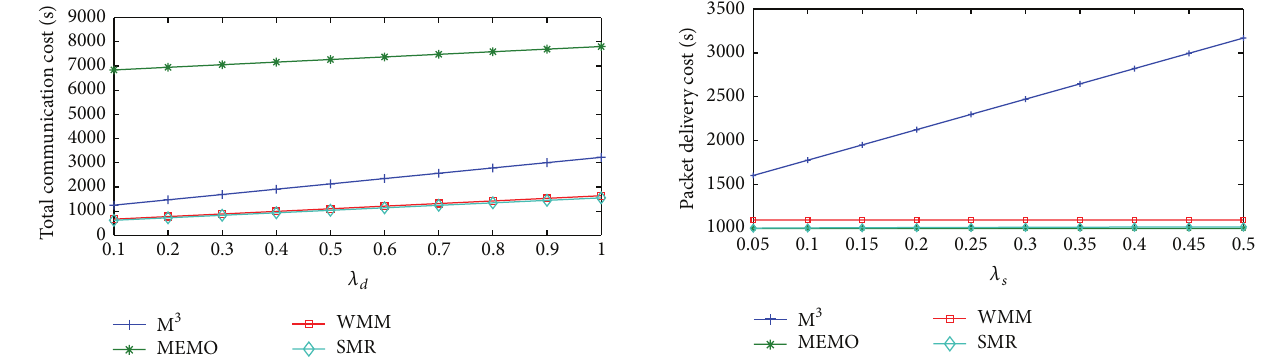
Figure 11: Packet delivery cost/sec versus 𝜆 𝑠